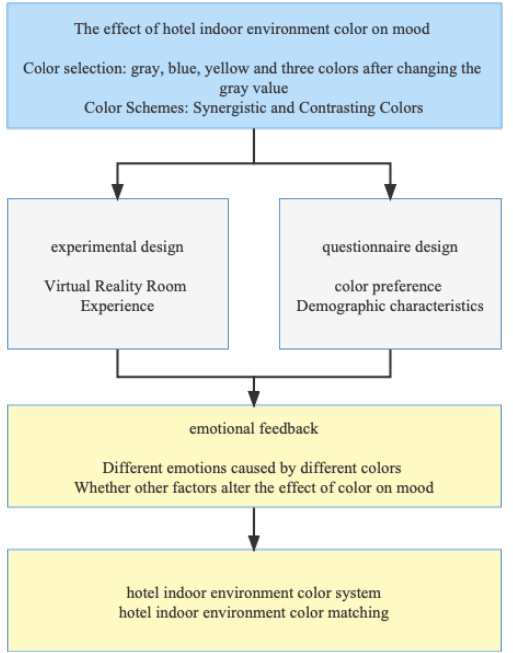
Figure 1. Experimental simulation diagram and their relevant parameters.